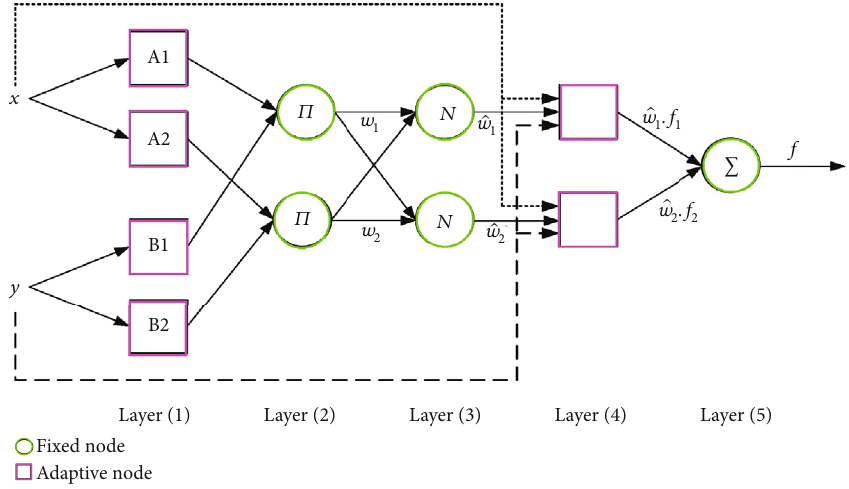
Figure 1: Structure of a typical ANFIS